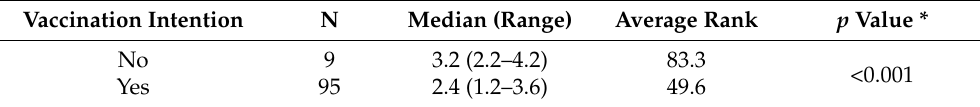
Table 4. Kruskal-Wallis